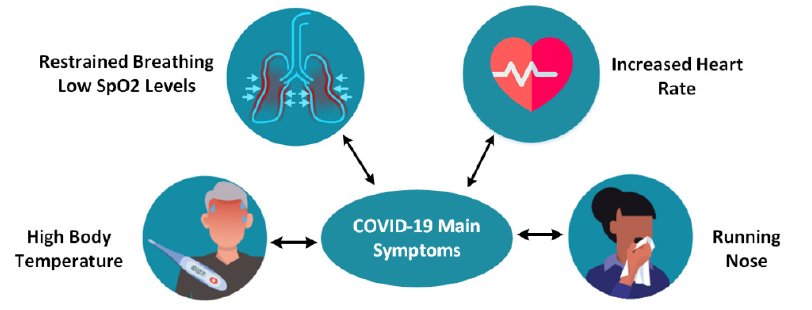
Figure 2. COVID-19 disease symptoms.